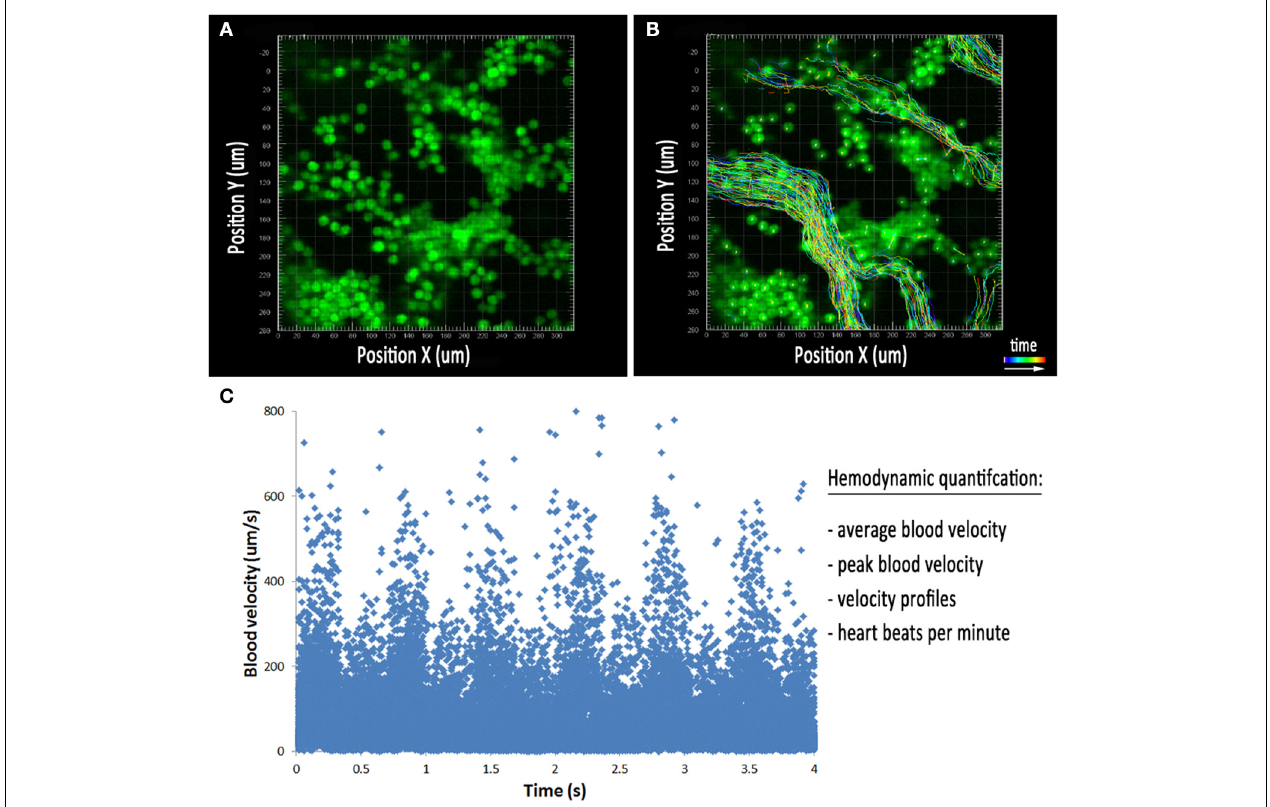
FIGURE 3 | Hemodynamic analysis in the embryonic yolk sac. (A) Cultured embryos with erythrocytes labeled using the ε -globin-GFP transgene near the blood islands at E8.5. (B) Tracks of all cells detected using image processing software during the movie represented in (A) . The colored